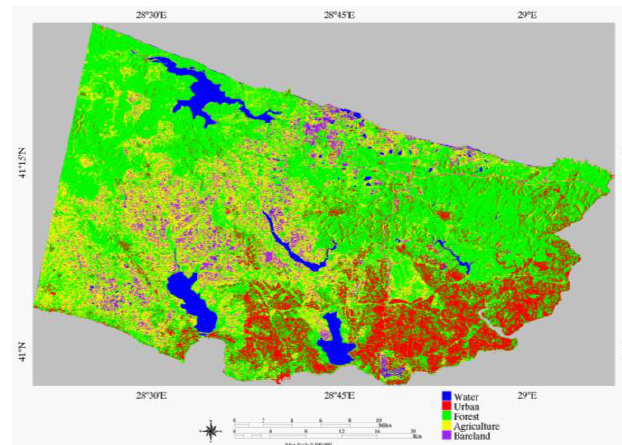
Figure 5. Classification result of VV,VH